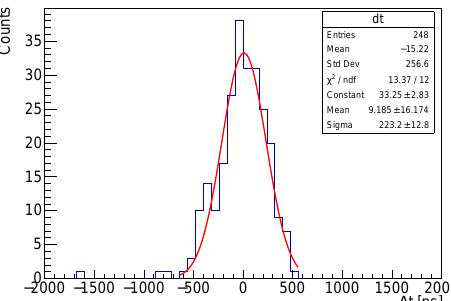
Figure 7. Coincidence time spectrum of annihilation gammas from 22 Na, detected by crystals from GaGG Modules I and II, both at V OV = 4